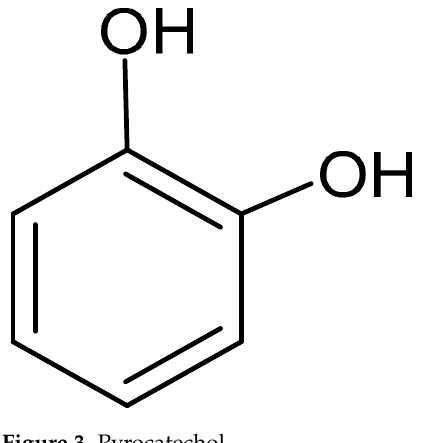
Figure 3. Pyrocatechol. Figure 4. Nonanal.